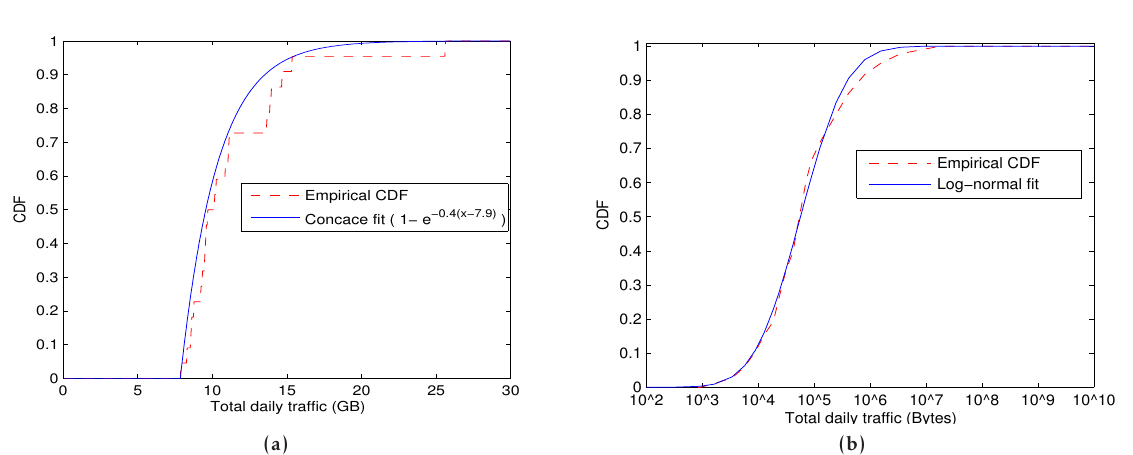
Figure 1. a) Empirical distribution of traffic from a Wi-Fi hotspot along with a concave fit, b) Empirical distribution of cellular traffic with a log-normal